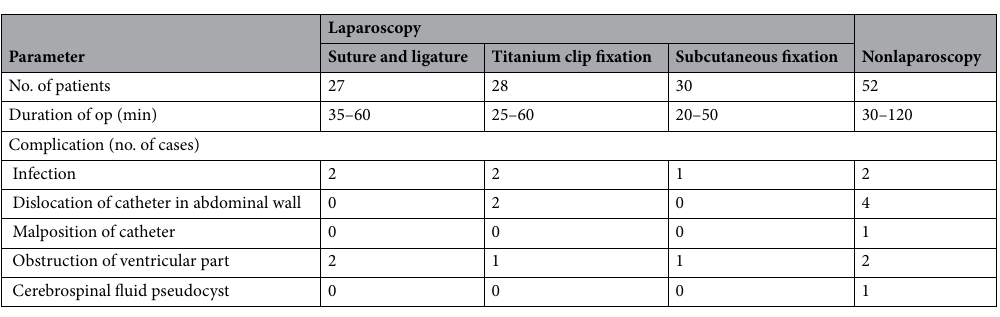
Table 2. Comparison of results between laparoscopic and nonlaparoscopic groups.